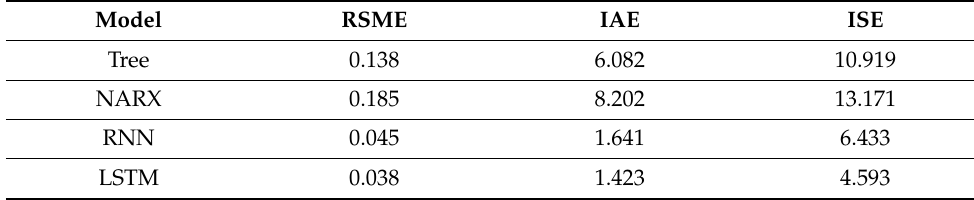
Figure 11. Prediction trends with different learning models (70% data for model training). Table 6. Comparison of different learning models in model